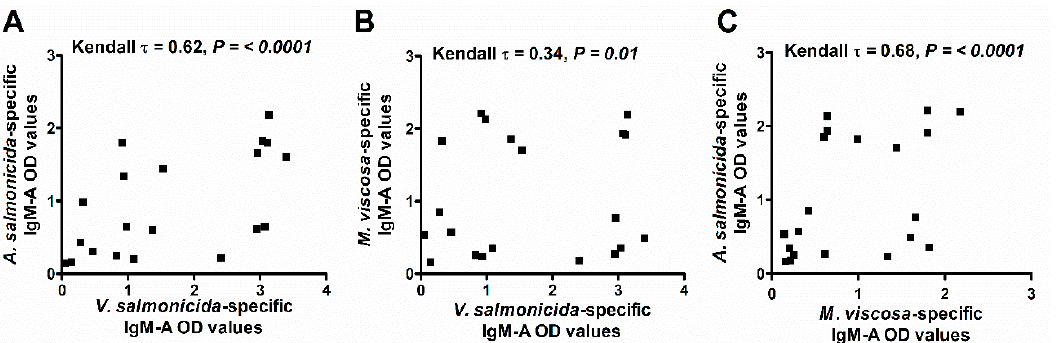
Figure 3. Scatter plots of specific IgM-A antibody responses (ECAS-CIA OD values) in scraped skin mucus to three different bacterial antigens. The three panels also show the results of Kendall’s rank tests of the correlation ( τ ) between ECAS-CIA OD values from the analysis against the bacterial antigens. ( A ) A. salmonicida versus V. salmonicida ( B ) V. salmonicida versus M. viscosa , and ( C ) A. salmonicida versus M. viscosa .